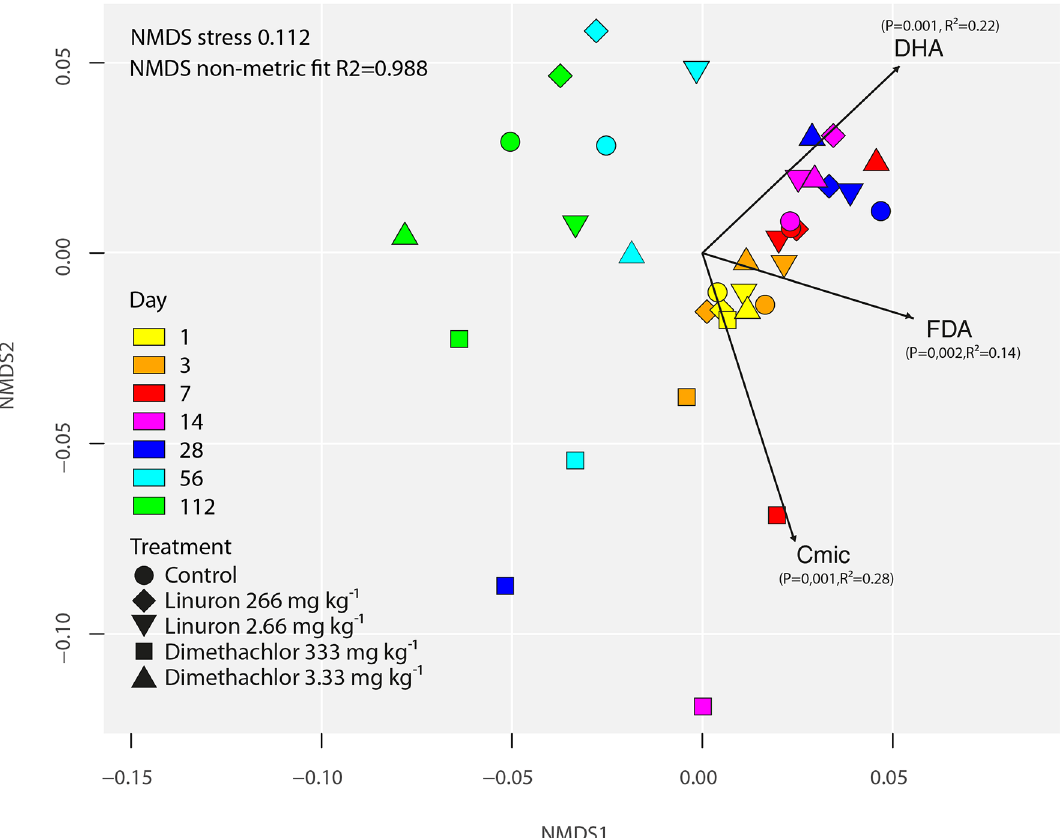
Figure 3. NMDS analysis of soil samples treated by herbicides linuron and dimethachlor. Arrows indicate vectors fitting for microbial biomass carbon Cmic, Fluorescein diacetate hydrolysis FDA, and Dehydrogenase activity